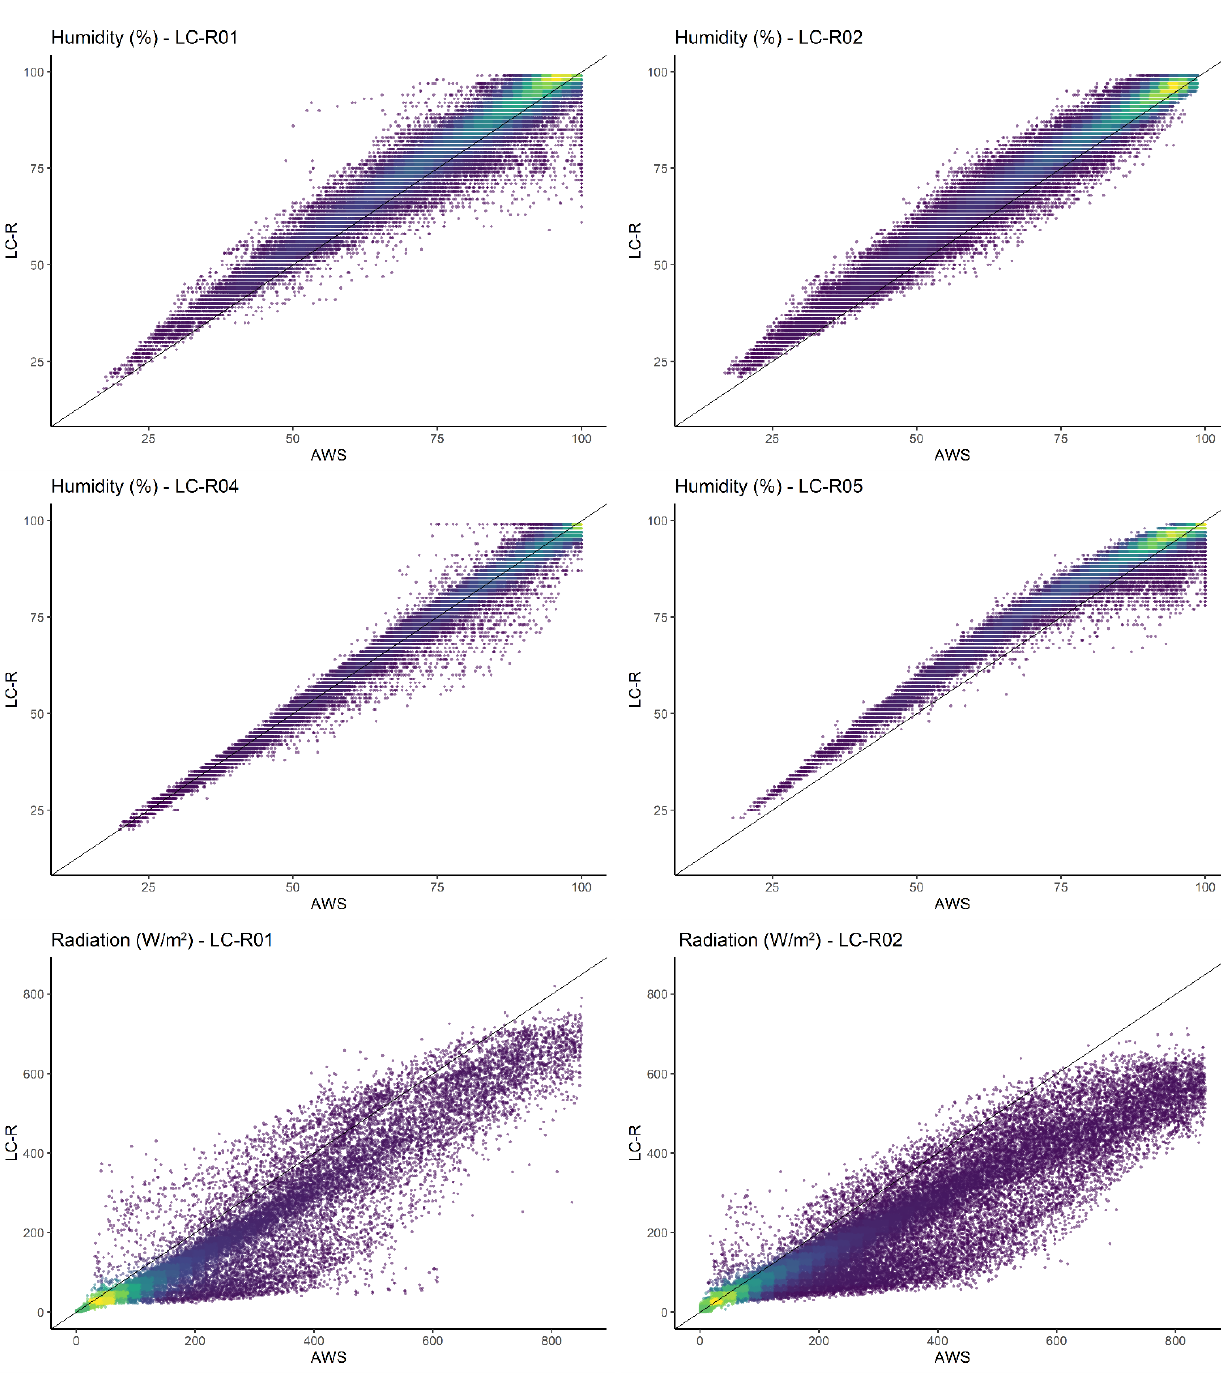
https://doi.org/10.5194/essd-14-4681-2022 Earth Syst. Sci. Data, 14, 4681–4717,